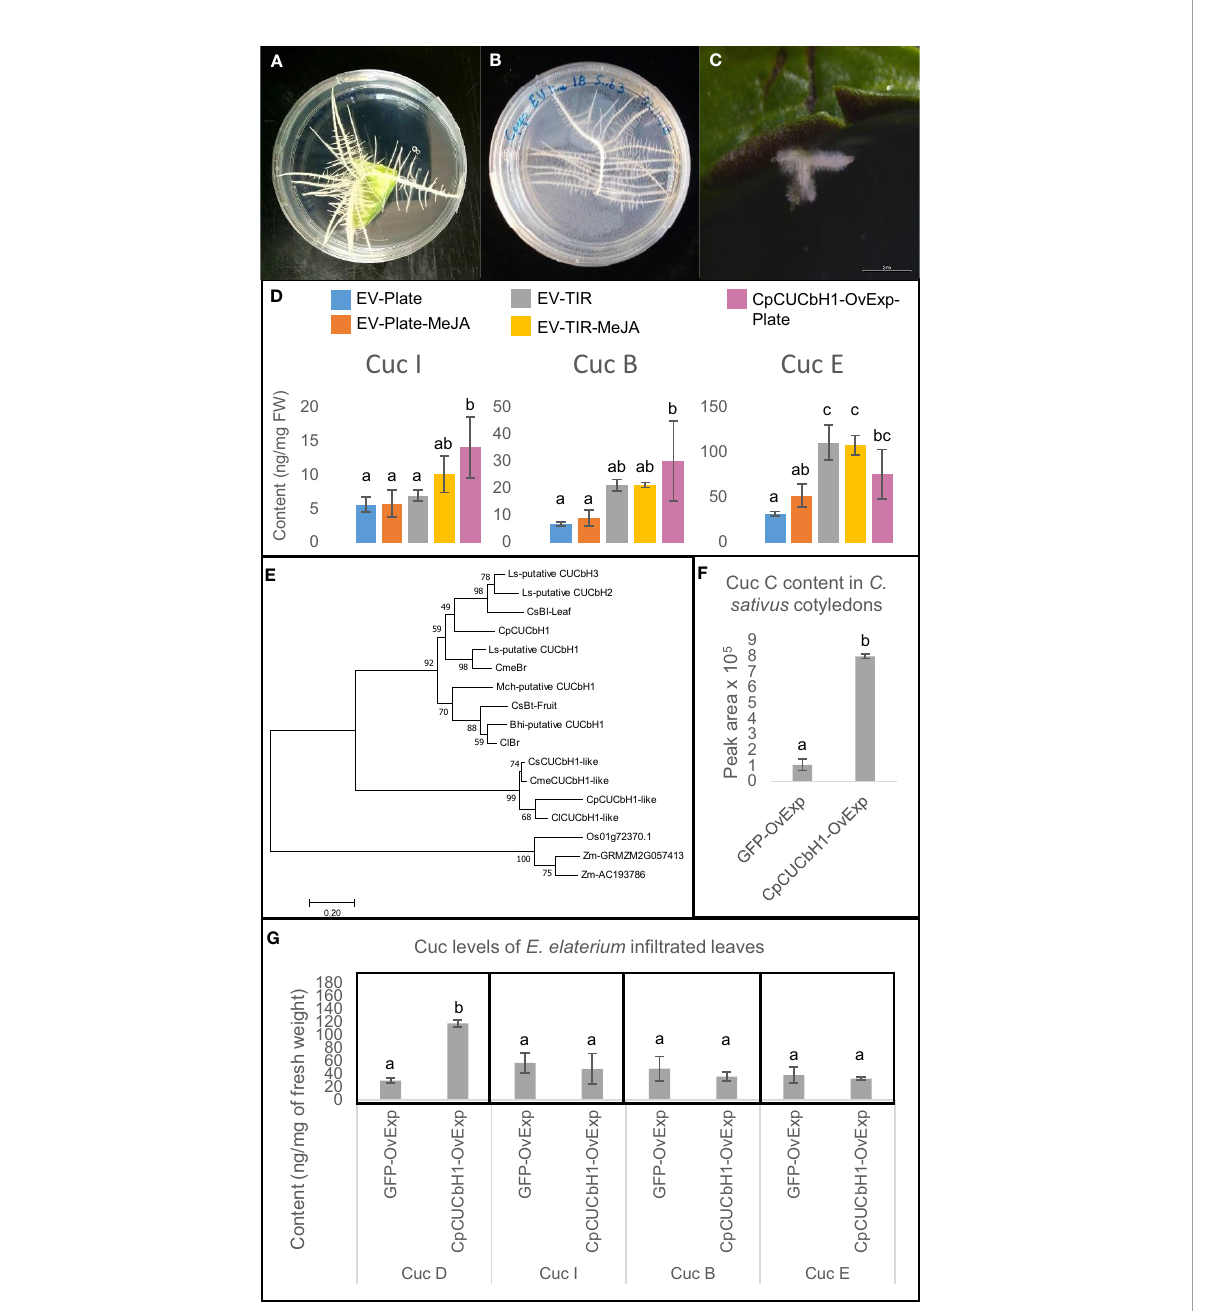
FIGURE 3 Cucurbitacin production in C.ucurbita pepo hairy roots can be increased by overexpression of C.pCUCbH1 and cultivation methods. (A) Hairy roots emerging from C. pepo cotyledon 2 weeks after transformation. (B) C. pepo hairy roots propagation on agar plate. (C) hairy roots emerging